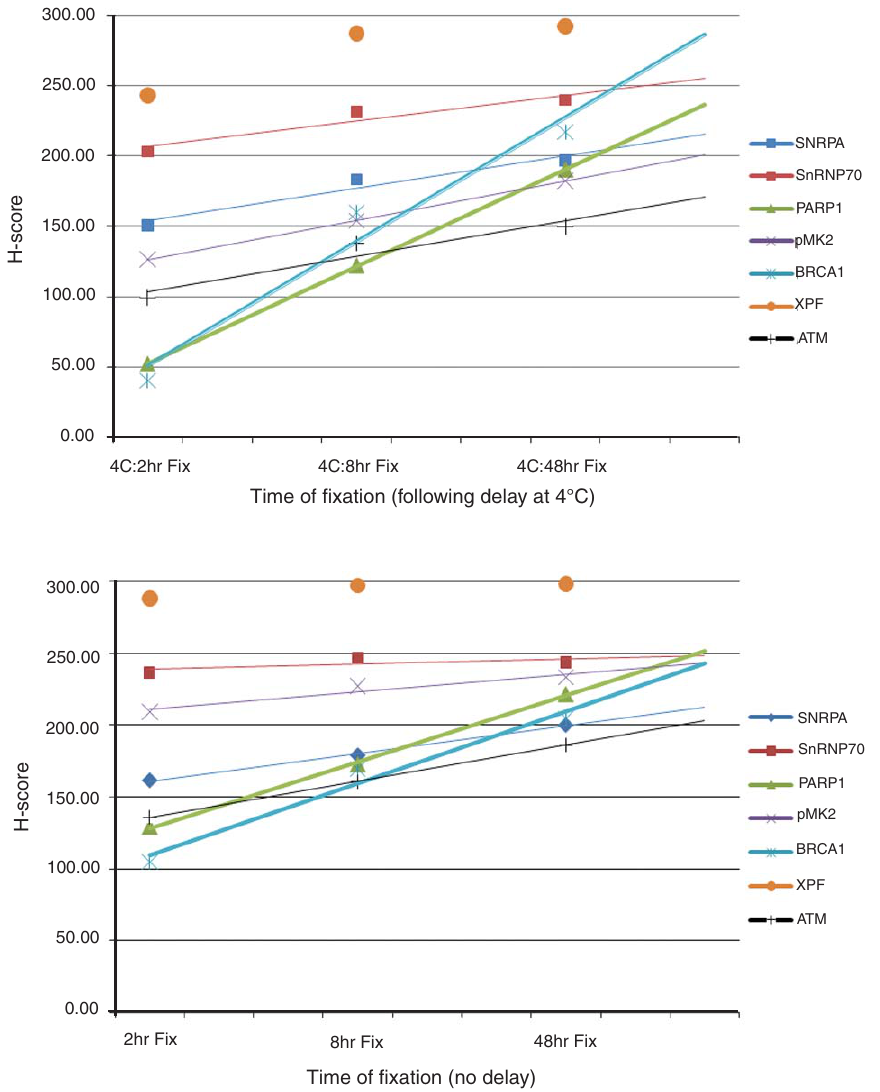
Fig. 5. Biomarkers co-vary in H-score relative to fixation conditions. Samples were either fixed for the indicated time or held overnight at 4 ◦ C prior to fixation for indicated times. Trend lines are added for comparison of different biomarkers H-scores across the different